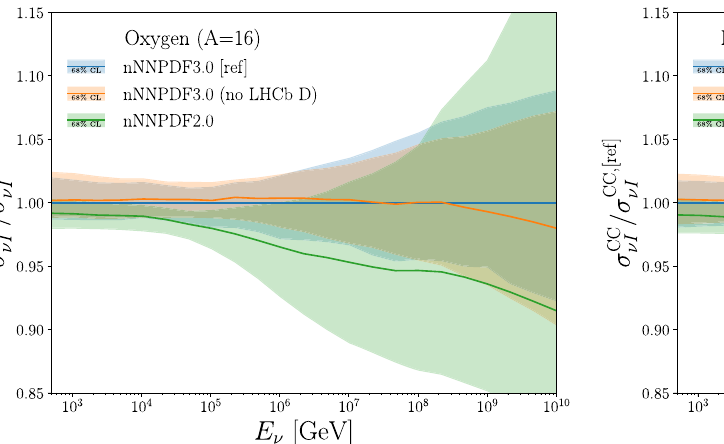
Fig. 30 Comparison of the inclusive CC neutrino-nucleon cross- section as a function of incident neutrino energy for different nPDF sets. Predictions are shown for an isoscalar nuclear target with A = 16